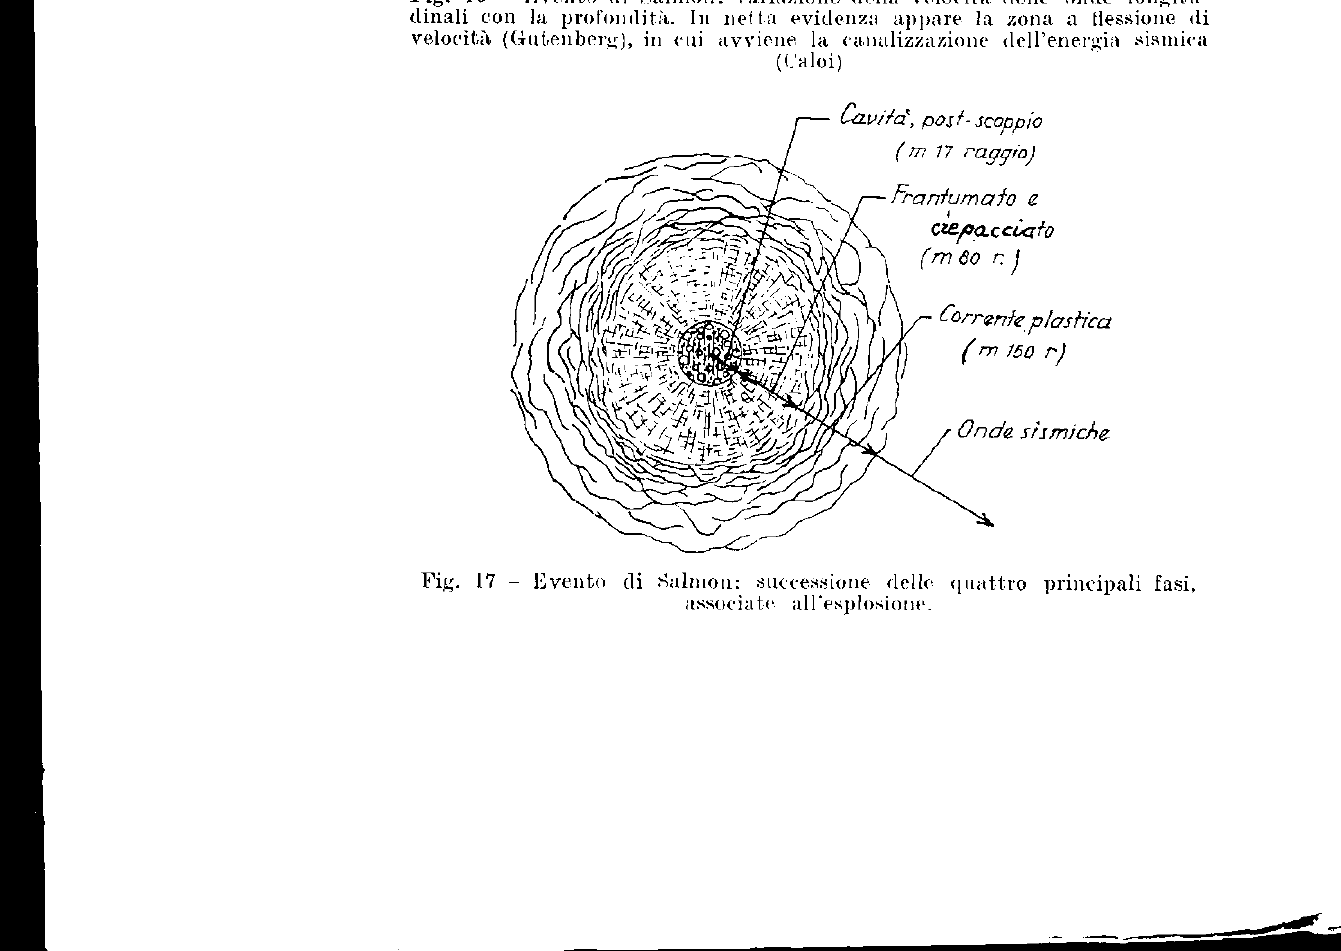
Fig. 16 - Evento di Salinoli: variazione della velocità delle onde longitu- dinali con la profondità. In netta evidenza appare la zona a flessione di velocità (Gutenberg), in cui avviene la canalizzazione dell'energia sismica (Caloi)